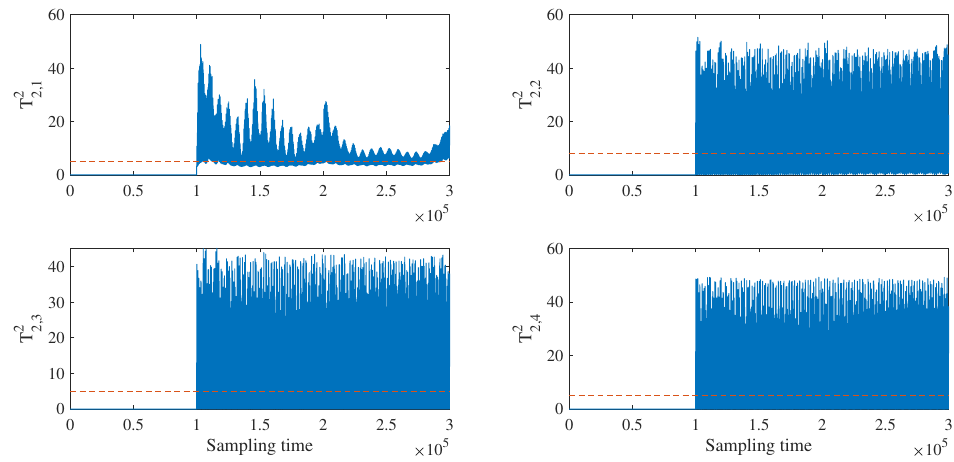
Figure 15. Deep PCA-based fault detection for f 1 with FNR enhancement.